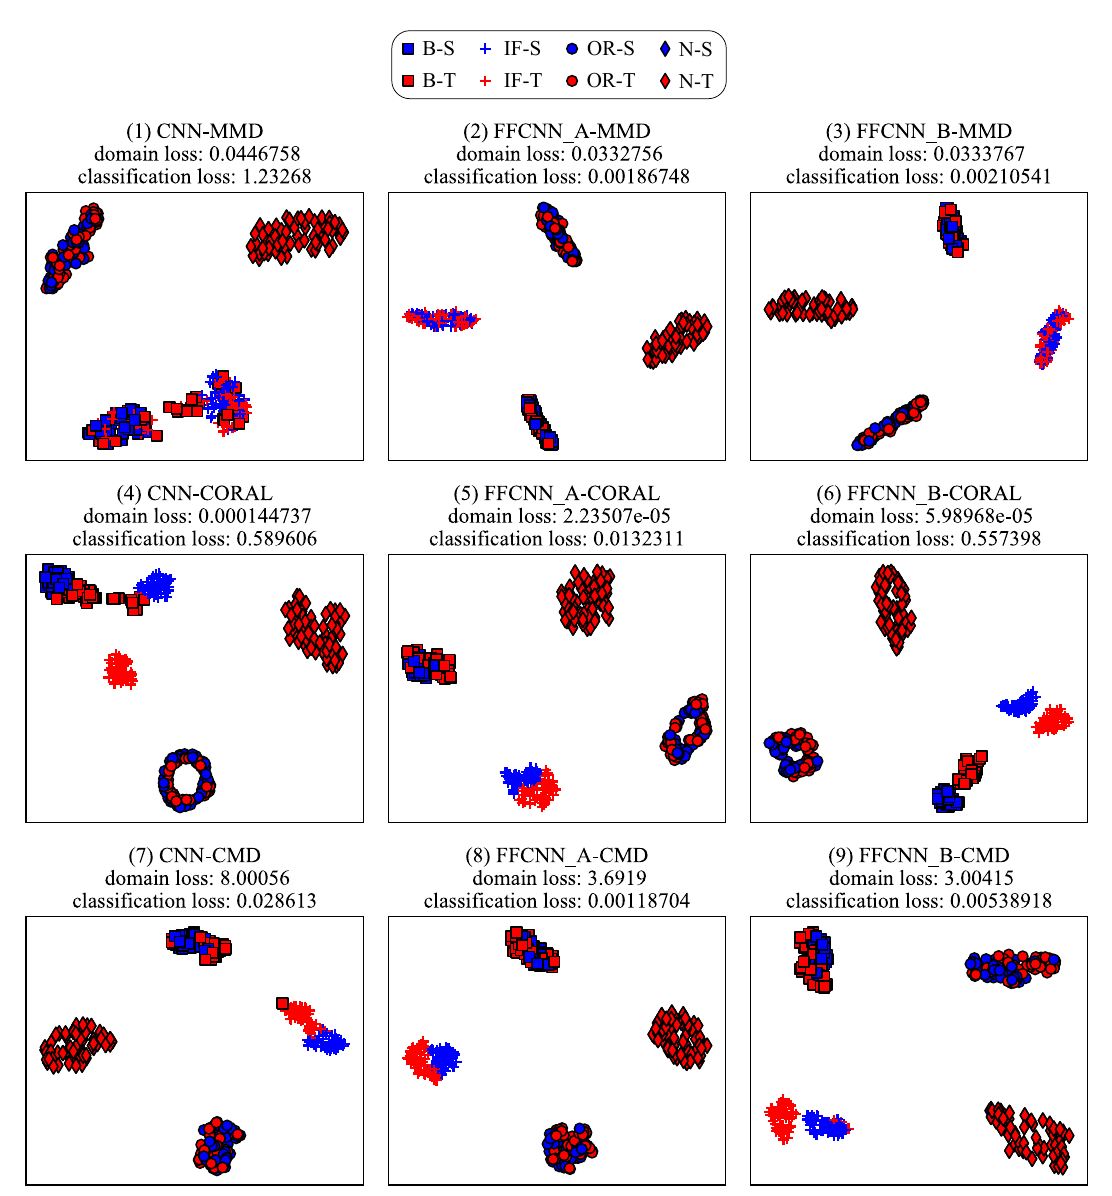
Figure 11. The visualization of learned features on CWRU dataset. The blue markers represent the source domain, the red markers represent the target domain. They are obtained from task B 4 → B